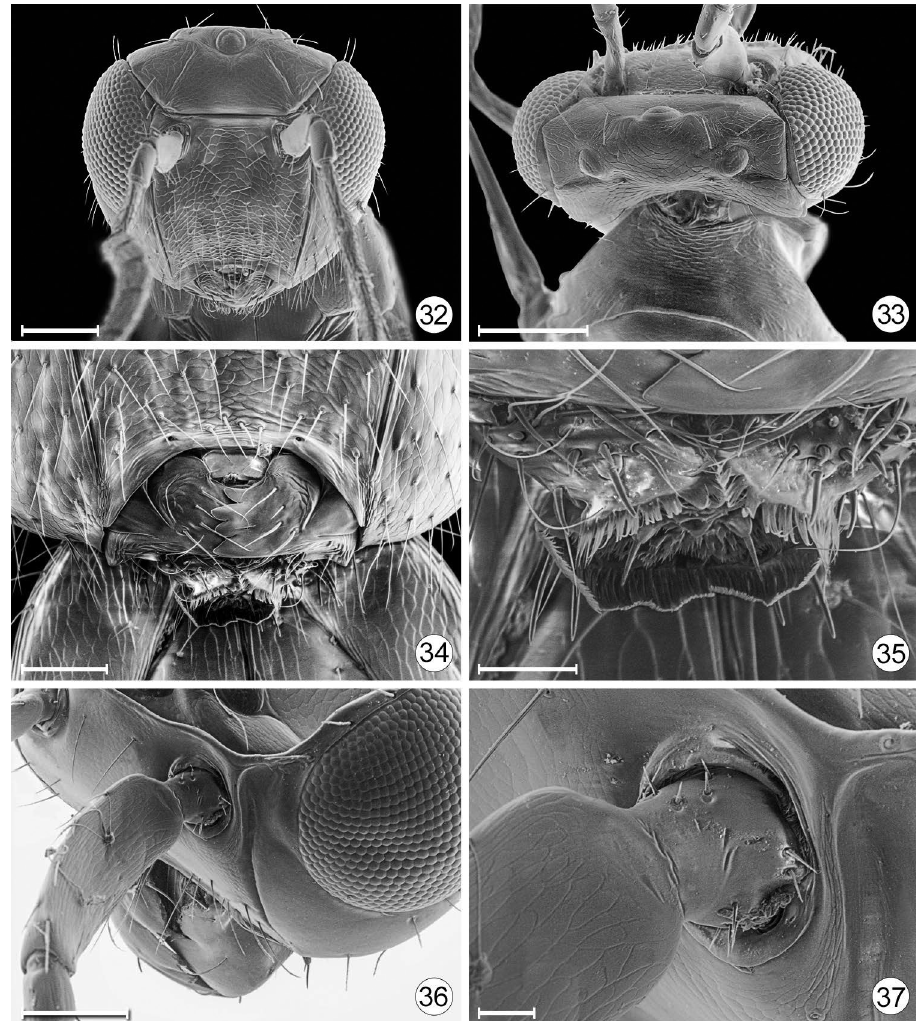
Figures 32–37. Neotriadomerus spp. 32 N. gloriosus female head, anterior 33 N. darlingi male head + pronotum, dorsal 34 N. gloriosus lower face + mouthparts, anterior 35 N. gloriosus maxillae + labium, anterior 36 N. longissimus head, scape and mandibles, dorsoanterolateral 37 N. longissimus radicle, ante- rolateral (and showing 3-way junction of transverse, supraorbital and preorbital trabeculae). Scale bar for 32, 33, 36 = 100 μm; 34 = 50 μm; 35, 37 = 20 μm.